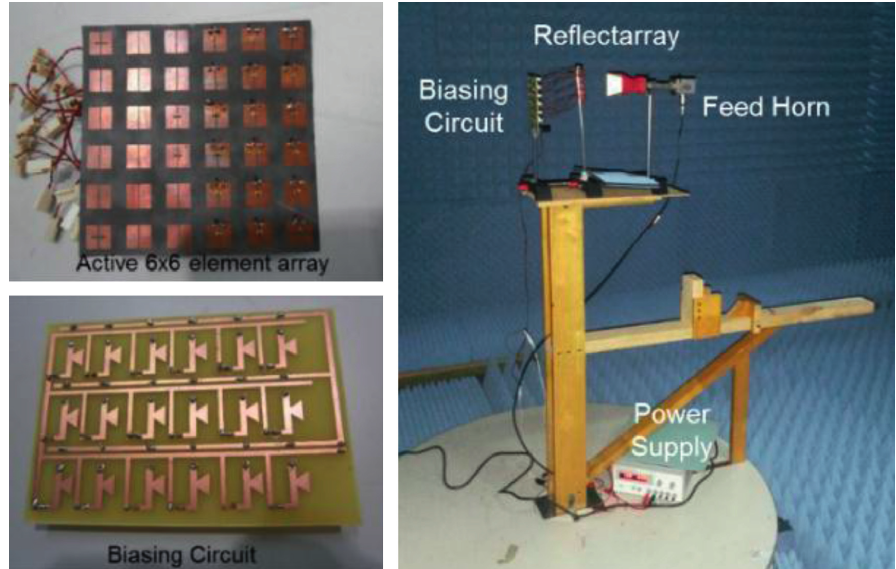
Figure 5: Fabricated 6 × 6 element active array, biasing circuit, and complete far-field measurement setup for an active reflectarray